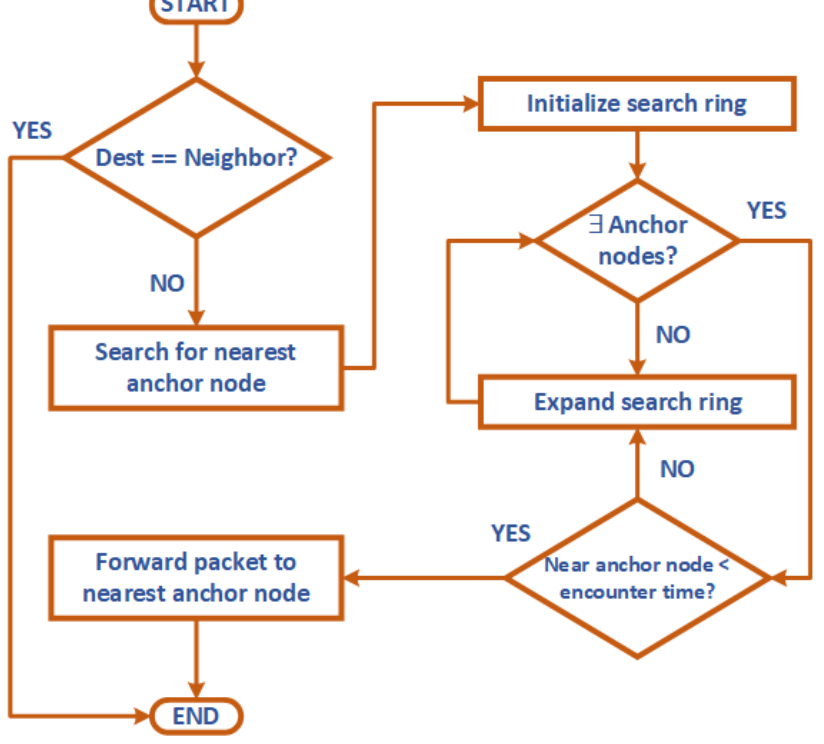
Figure 3. Flowchart of FRESH